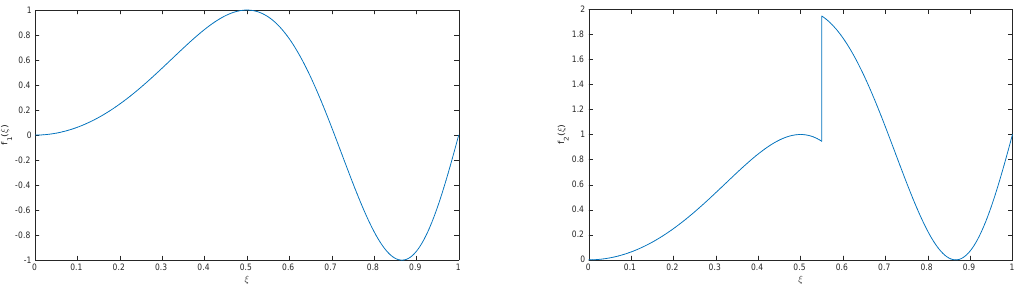
Fig. 2 Graphic representation of: left, f 1 ; right, f 2 . Both functions are defined in